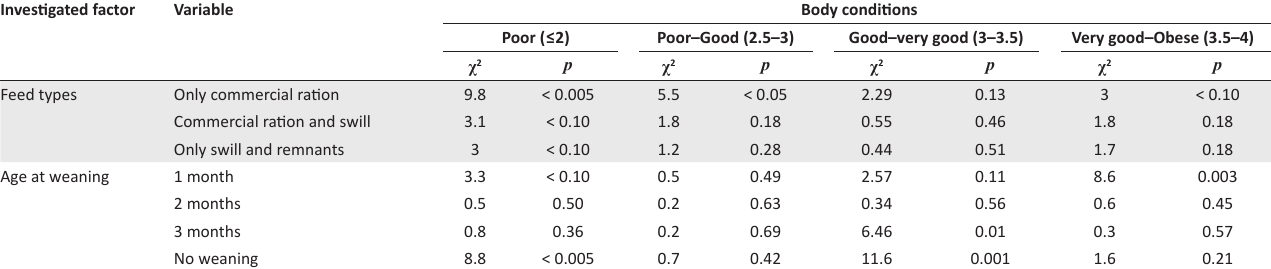
TABLE 3: Association between body condition scores, types of feed used and age at weaning. Investigated factor Variable